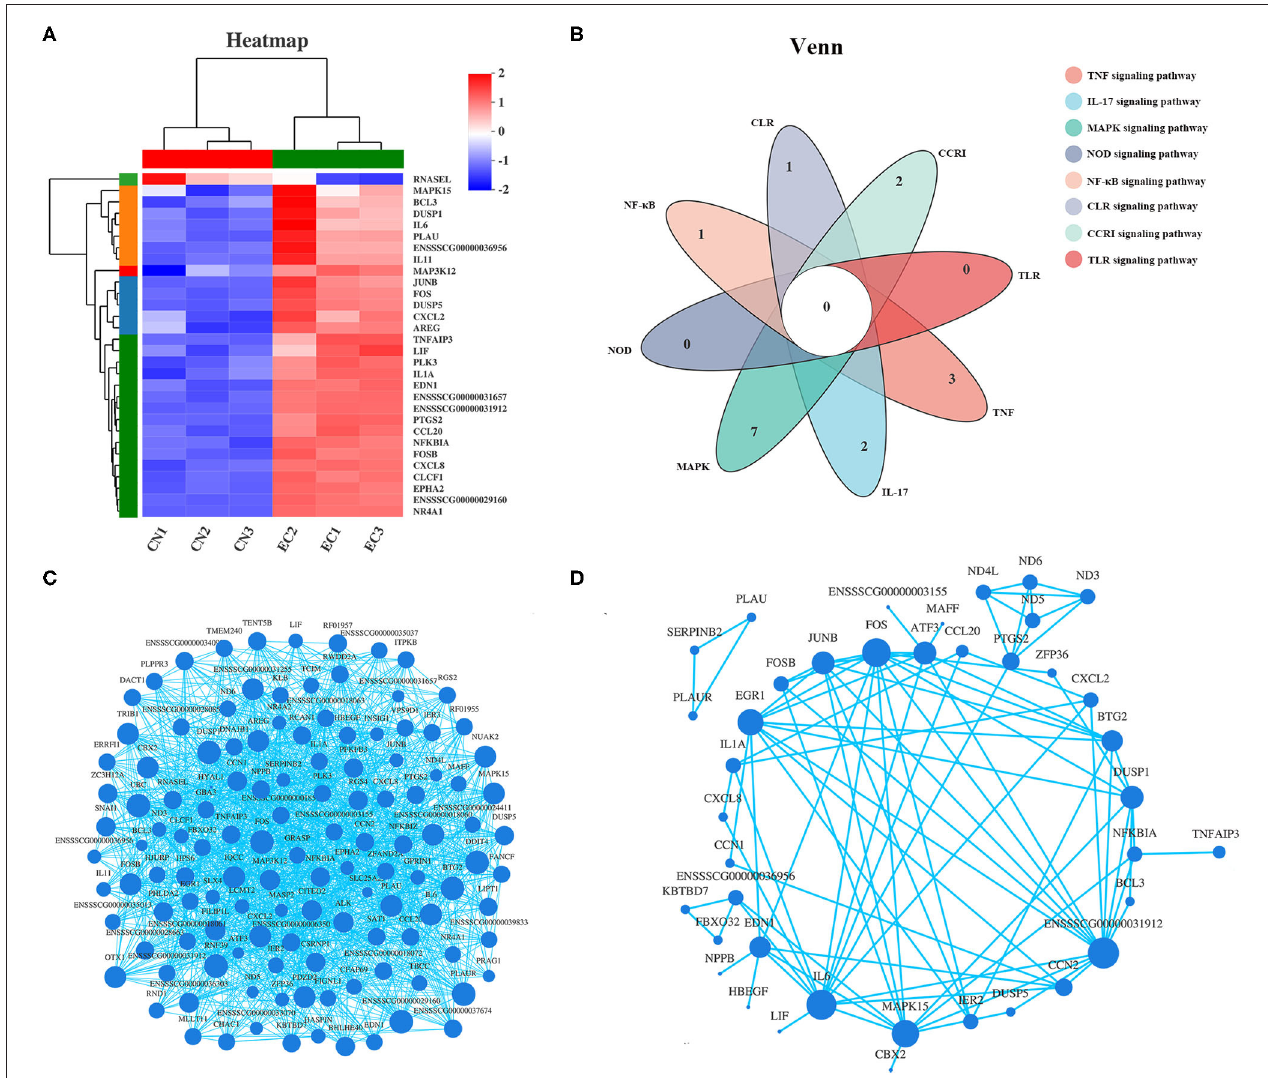
FIGURE 7 | Expression pattern of “core DEGs.” (A) Heatmap of “core DEGs” showing expression profile in CN and EC groups. (B) Venn diagram of “core DEGs” enriched in immune response-related pathways. (C) Correlation analysis and (D) protein–protein interaction of gene expression of 131 referenced DEGs providing a rationale for functional significance of “core DEGs.” Size of each node corresponded to number of connections (degree).